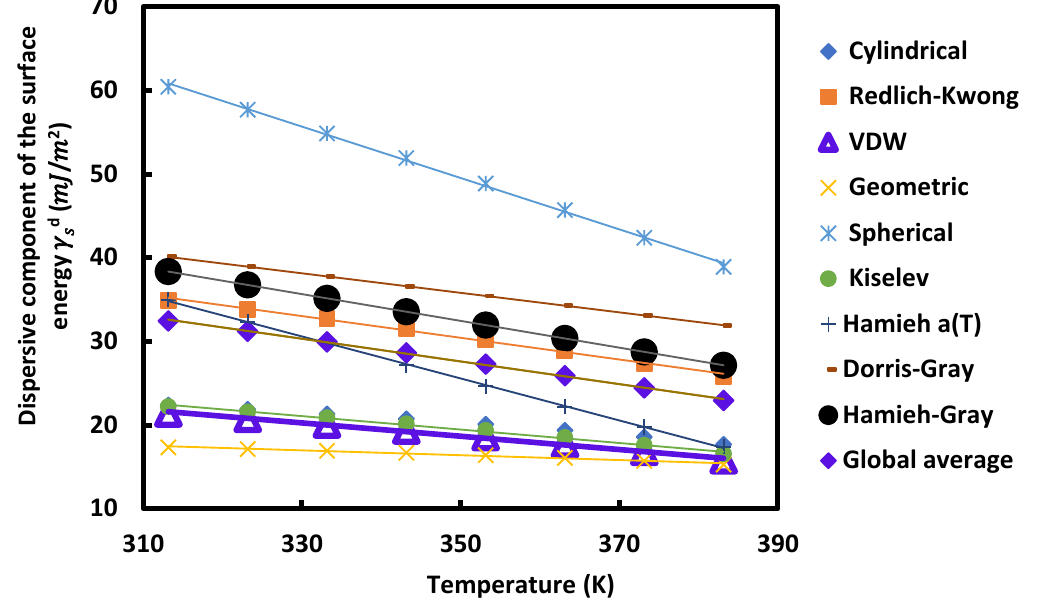
(cid:0) (cid:1) mJ/m 2 of UiO-66-00 as a